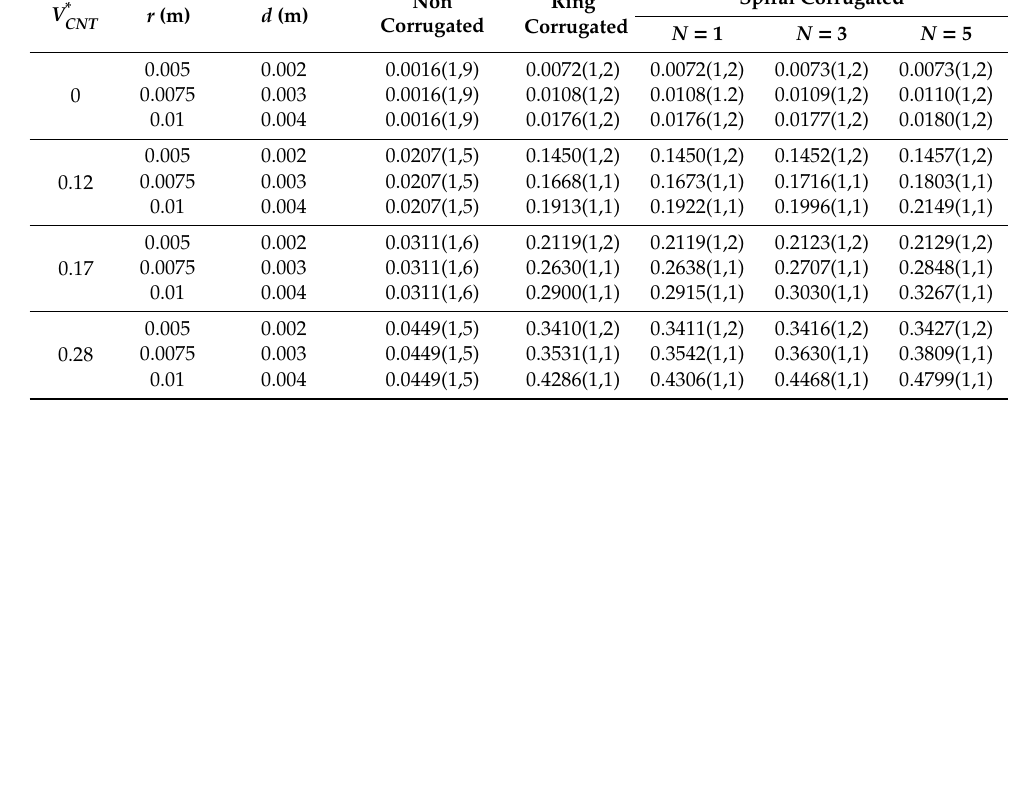
Table 3. E ff ects of geometrical parameters of corrugation and CNT volume fraction V ∗ critical buckling of corrugated uniformly distributed carbon nanotube-reinforced composite (UD- CNTRC) cylindrical shells (round corrugation) (in MPa).